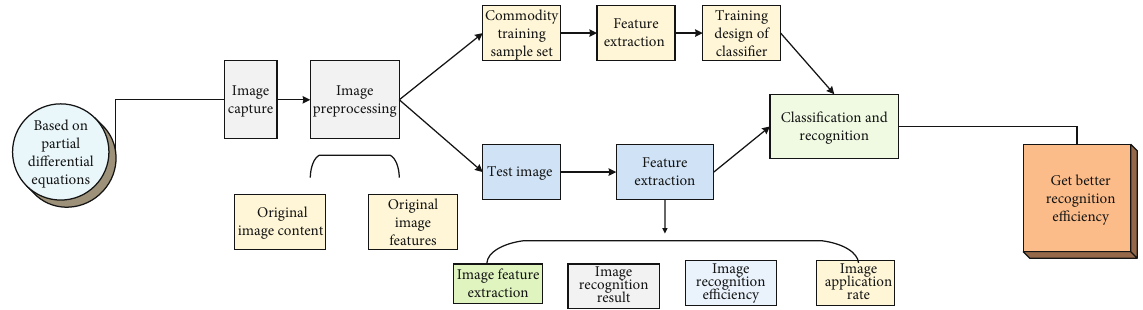
Figure 1: Inventory identi fi cation process.